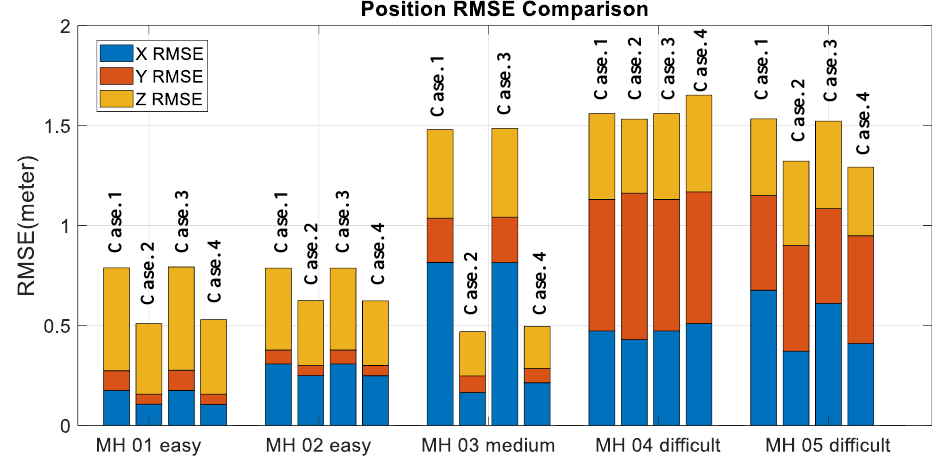
Figure 19. Position accuracy comparison.